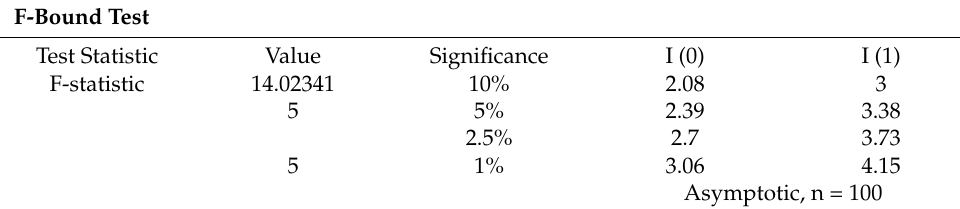
Table 3. The result of the bound